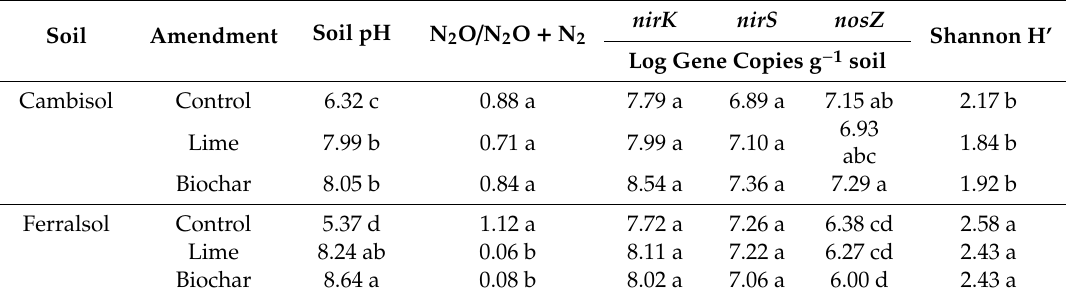
Means within a column followed by the same letter are not significantly di ff erent ( p >